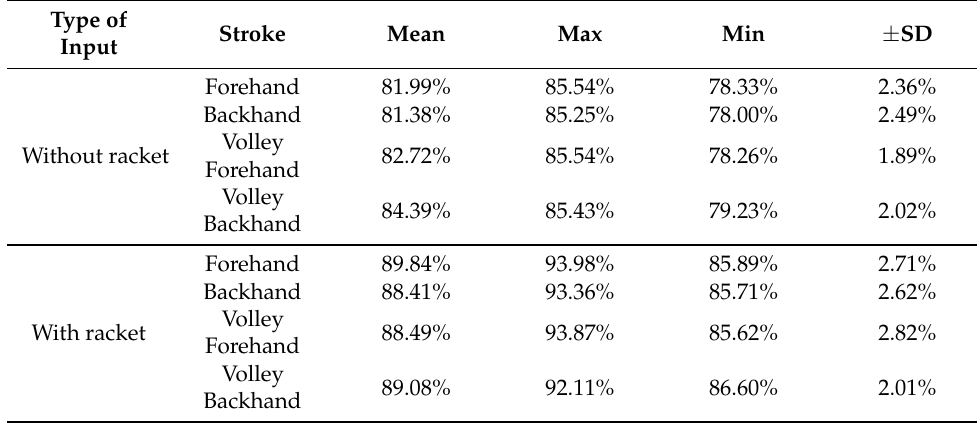
Table 2. Obtained Accuracies results for individual strokes.